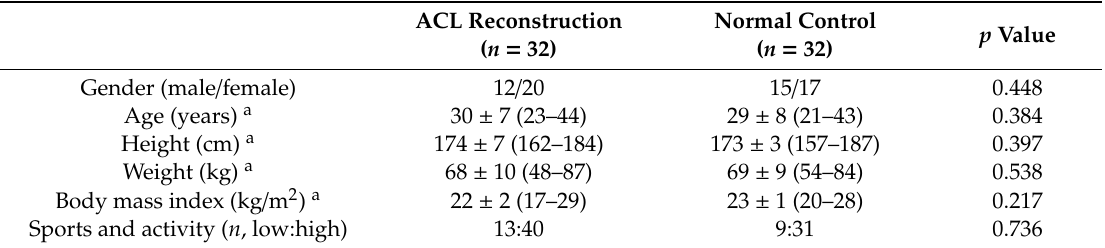
Table 1. Demographic data of enrolled patients and normal control